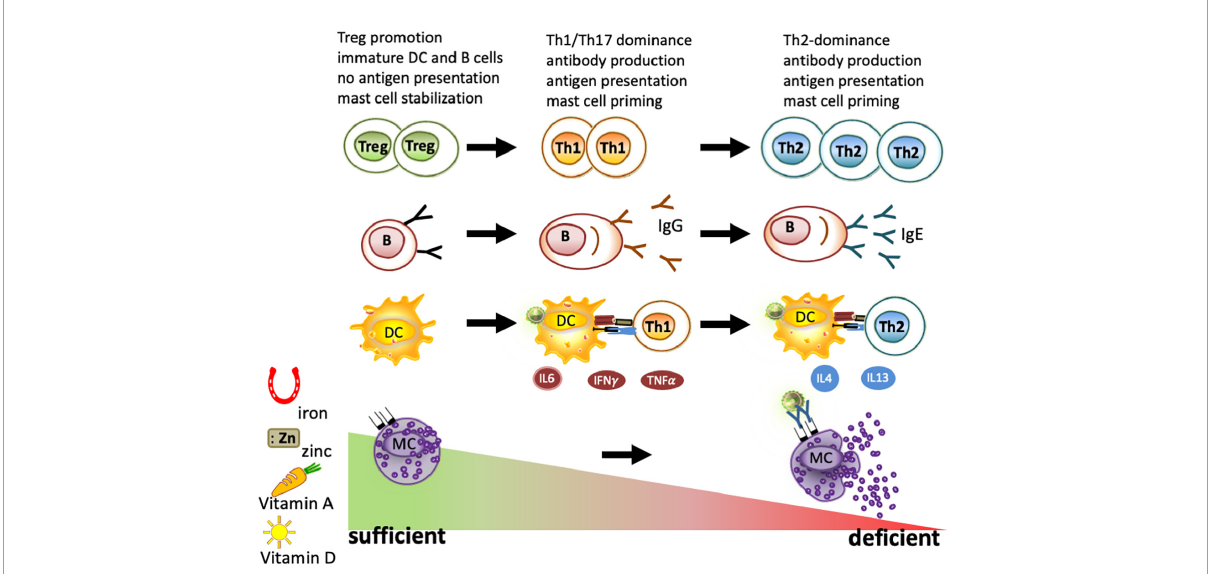
FIGURE2 Immune cells under deficient and sufficient conditions of iron, zinc, and vitamins A and D. As part of nutritional immunity, depletion of iron, zinc, vitamin A, and vitamin D leads to immune activation and may result in a strong Th1/Th17 dominated immune response and B-cell maturation to plasma cells. When these deficiencies persist, a Th2 milieu is generated due to the higher resistance of these cells to survive under nutrient-deprived conditions. Locally, iron depletion is sufficient for mast cell priming and to evoke degranulation. In contrast, the sufficiency of iron, zinc, and vitamins A and D is known to promote regulatory T cells and keep dendritic cells, B cells, and macrophages in an immature state. All these factors have been reported to lead to mast cell stabilization, thus reducing mast cell